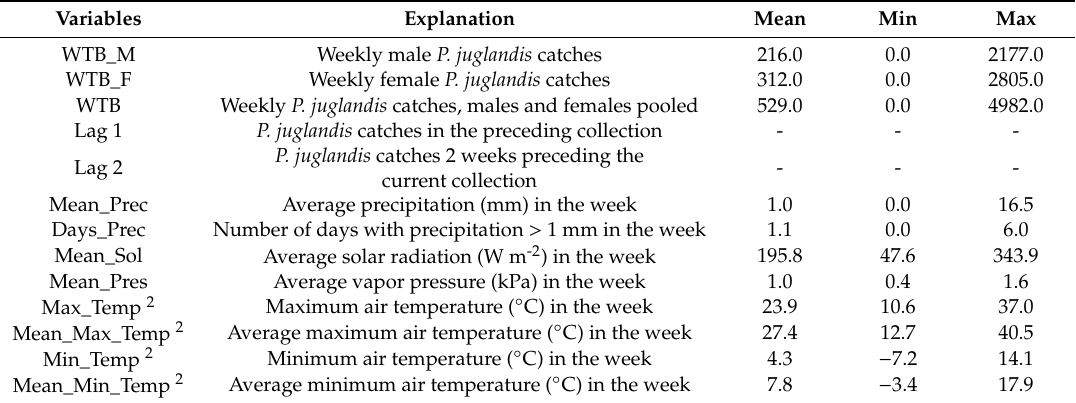
Table 1. Variables used to develop a flight model of weekly catches of walnut twig beetle